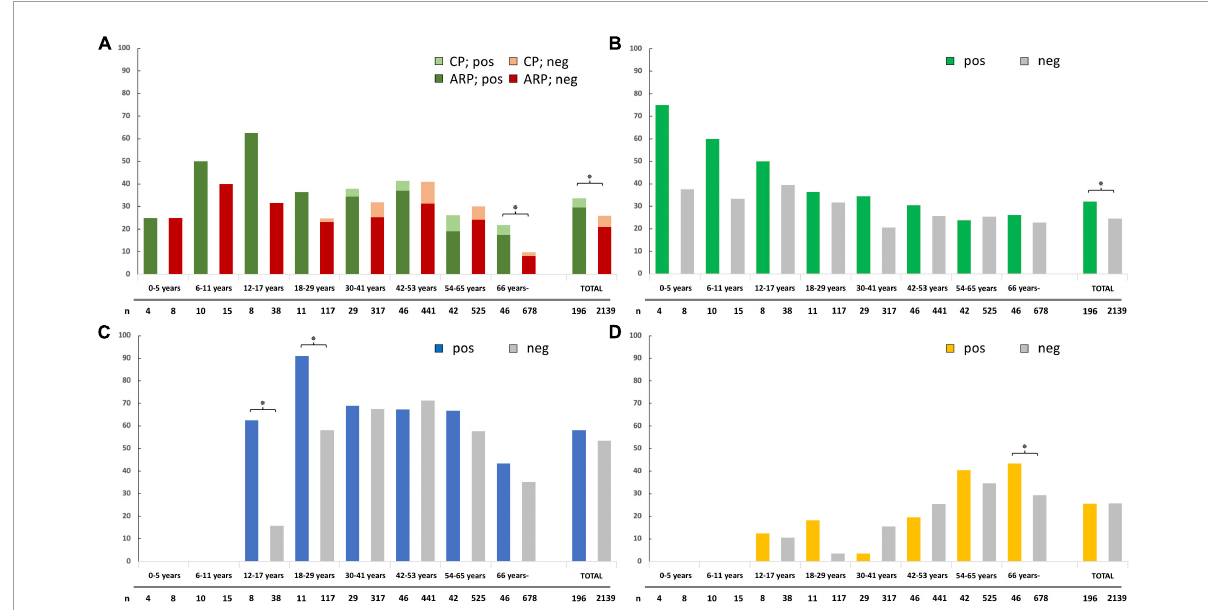
FIGURE1 (A) Rate of acute recurrent pancreatitis (ARP) and chronic pancreatitis (CP) in different age groups of acute pancreatitis (AP) patients with positive and negative pancreatic family history; (B) rate of idiopathic etiology at time of the index AP registry enrolment; (C) rate of current alcohol consumption and/or smoking at the time of the index AP registry enrolment; and (D) rate of diabetes and/or hyperlipidemia at the time of the index AP registry enrolment. The * sign indicates a statistically significant difference between positive and negative pancreatic family history groups ( < 0.05). n, total number of participants with data on the examined variable; CP, chronic pancreatitis; ARP, acute recurrent pancreatitis; pos, positive pancreatic family history group; neg, negative pancreatic family history group.